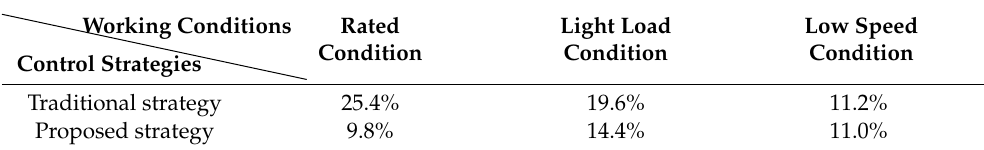
Table 2. Torque ripple rate K rT under different operating